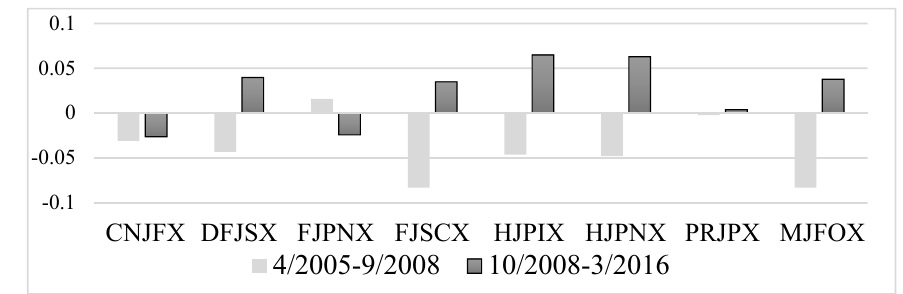
Figure 6 . Alpha/beta (in absolute values); benchmark: Mkt.